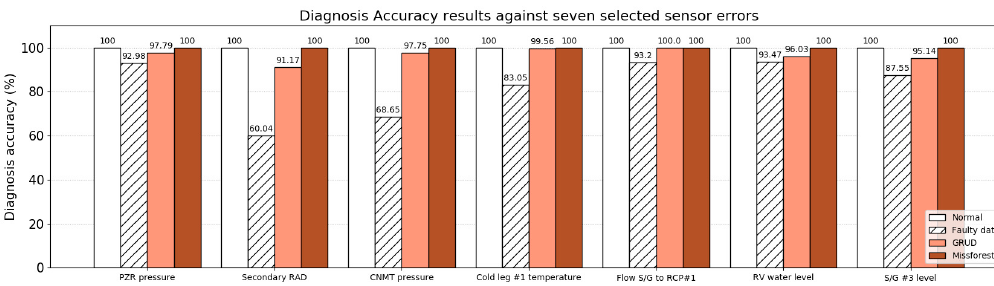
Table 5. The recovered diagnosis accuracy was directly affected by a degraded accuracy; for example, the lowest accuracy among the faulty data for ‘Secondary RAD’ is connected to the lowest recovered